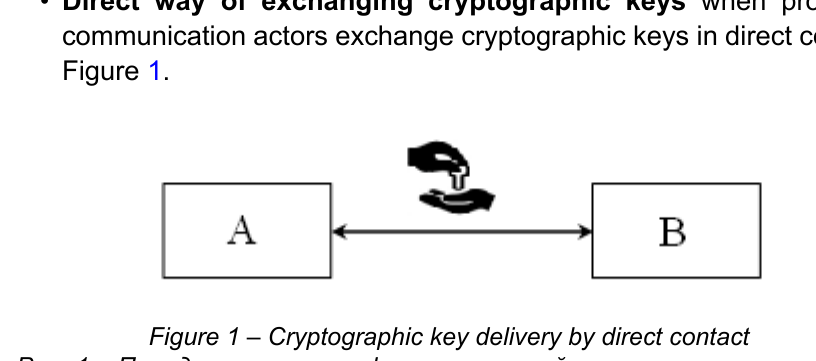
Figure 1 – Cryptographic key delivery by direct contact Рис. 1 − Передача криптографических ключей путем прямого контакта Слика 1 – Размена кључева у директном